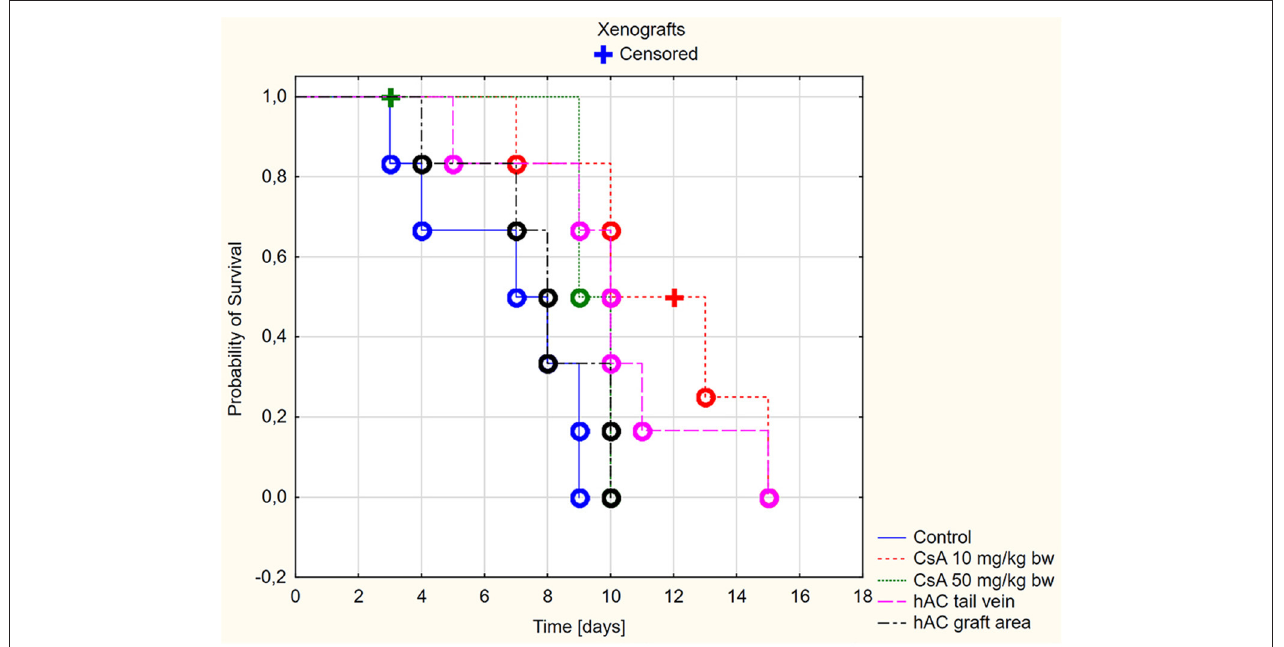
FIGURE 3 | Skin xenografts survival time. Censored ( + )—individuals that left the study before the day of massive graft rejection or on 15th day of breeding, due to severe side effects; Completed (o)—individuals observed until 15th day of breeding or until the graft massive rejection has occurred (80% of the graft surface necrosis).